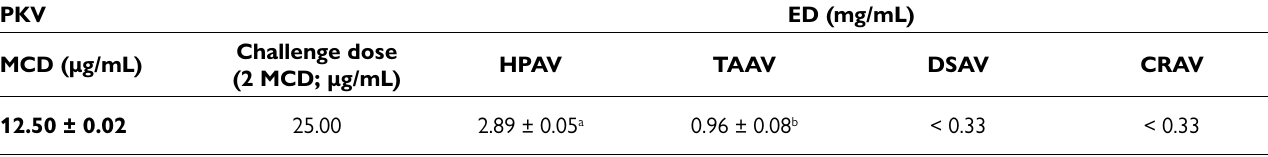
a,b The mean values for HPAV and TAAV using the Student’s t test showed significant differences (p < 0.001). MCD: minimum coagulation dose was defined as the amount of venom required to cause clotting of citrated human plasma in 3 min; ED: effective dose was defined as the dose of antivenom capable of prolonging the clotting time of challenge dose to 3 times that of the control. ED was expressed as the venom amount per unit volume of antivenom (mg/mL).